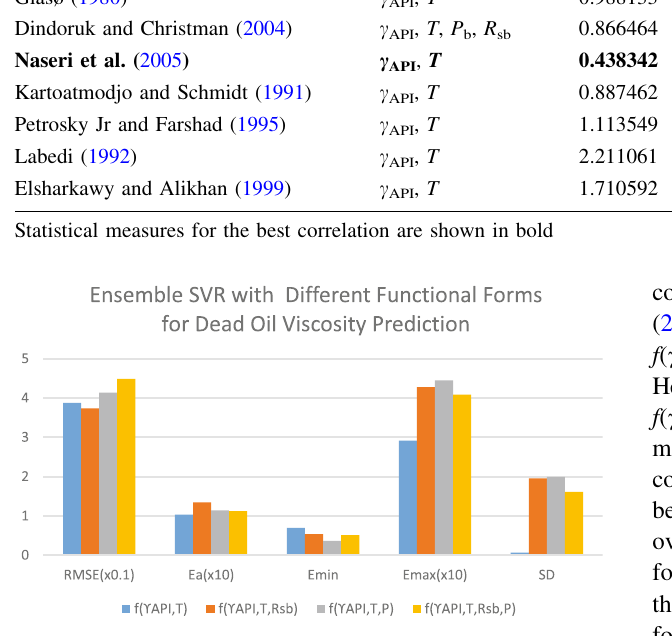
Fig. 1 Results of different functional forms for l od prediction with ensemble SVR